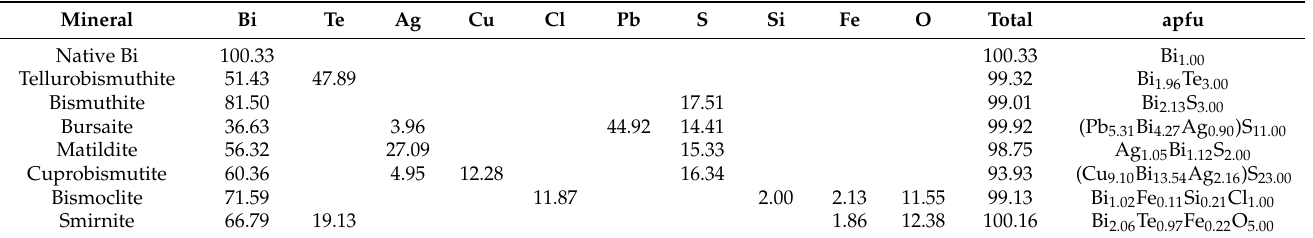
( f )—bismoclite crystal (Bmc) in quartz (Qz). Table 2. Chemical composition of bismuth minerals (in